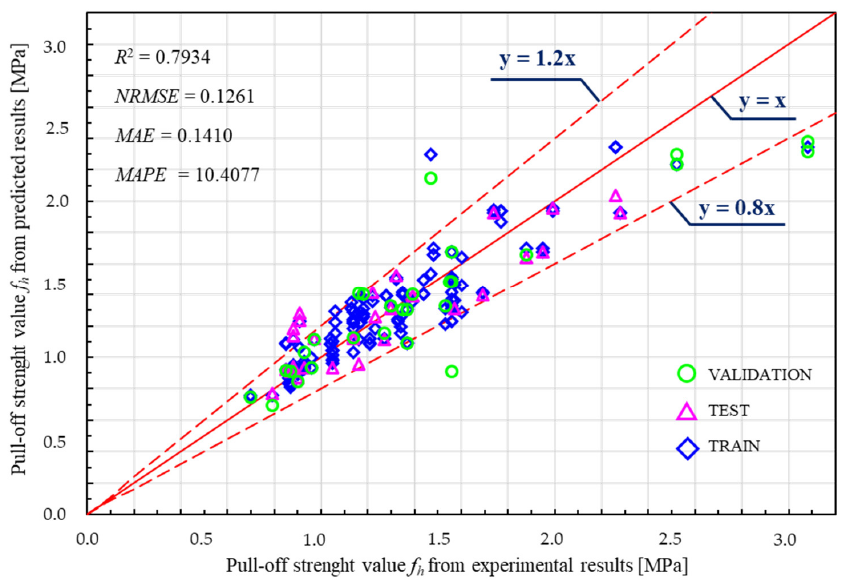
Figure 9. Relationship between the predicted value and the experimental value of the pull-off strength f h for ANN test, train, and validation process for the LM algorithm with one layer of hidden neurons.